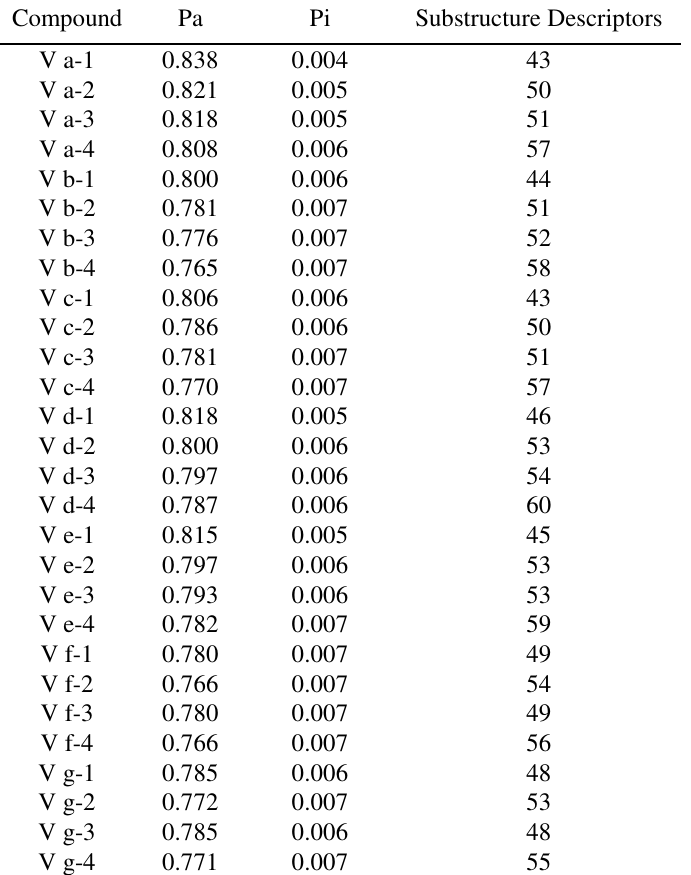
Table 12. QSAR Analysis of compounds V(a-g)(1-4)Activities with Pa>70%Only 1 Possible activitiy at Pa>70%HDL-cholesterol increasing